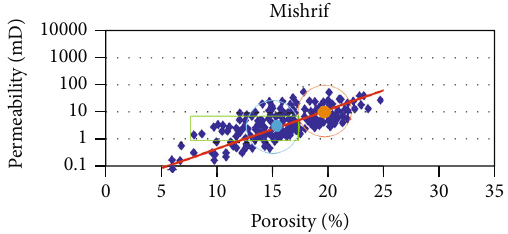
Figure 6: The relationship between porosity and permeability in Mishrif